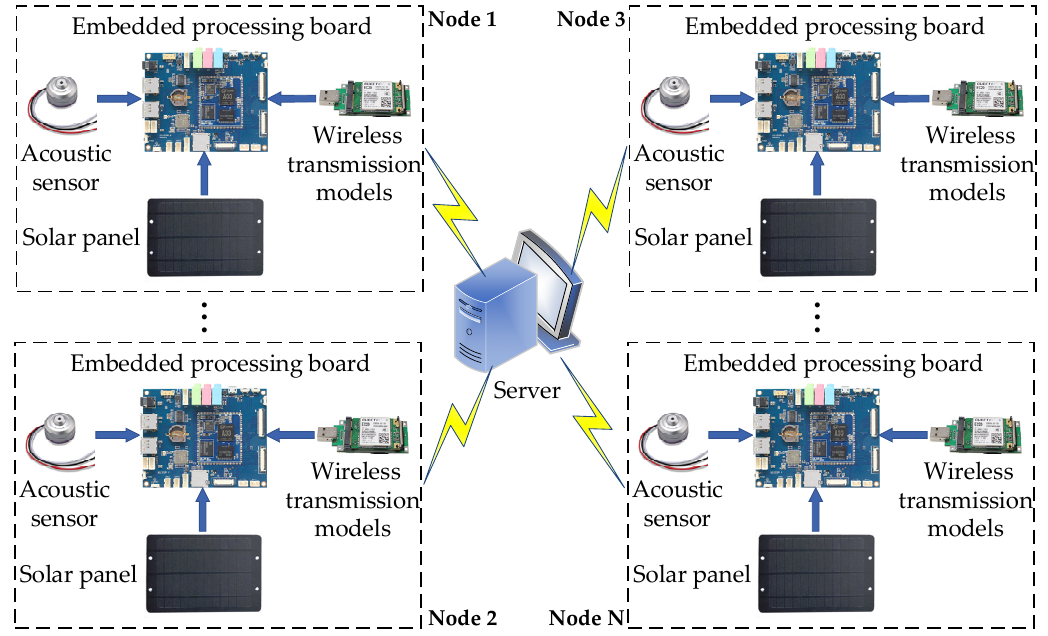
Figure 1. Th e overview of the proposed system. Figure 1. The overview of the proposed